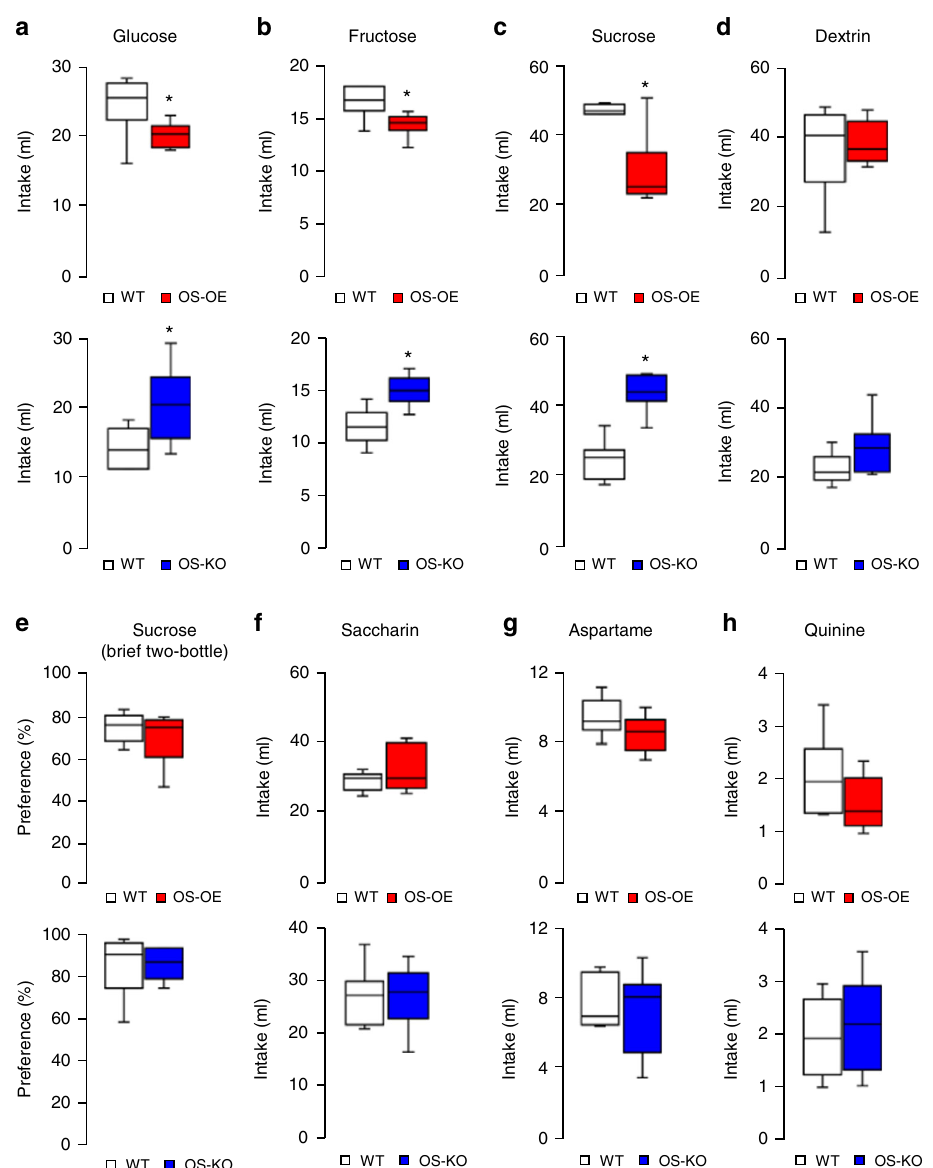
Fig. 4 SIRT1 in Oxt neurons speci fi cally regulates preferences for simple sugars. Two-bottle choice tests in OS-OE (red) and OS-KO (blue) mice. a – d Results of 3-day two-bottle choice tests (100 mM glucose ( a ), 100 mM fructose ( b ), 100 mM sucrose ( c ) and 2% dextrin ( d )) ( n = 7 in the WT group; n = 6 in the OS-OE and OS-KO groups). e Results of 10-min brief access two-bottle choice tests for 100 mM sucrose over water ( n = 6 per group). f , g Results of two-bottle choice tests with arti fi cial sweeteners (0.2% saccharin ( f ) and 0.2% aspartame ( g )) over water, given for 3 days in sugar-naive mice ( n = 8 per group). h Results of 3-day two-bottle choice tests with 1.5 mM quinine (bitter taste) ( n = 7 in the WT group; n = 6 in the OS-OE and OS- KO groups). Data are shown as box and whisker plots (centre line, median; box limits, upper and lower quartiles; whiskers, the minimum and maximum value of a data set). * p < 0.05. See also Supplementary Fig.